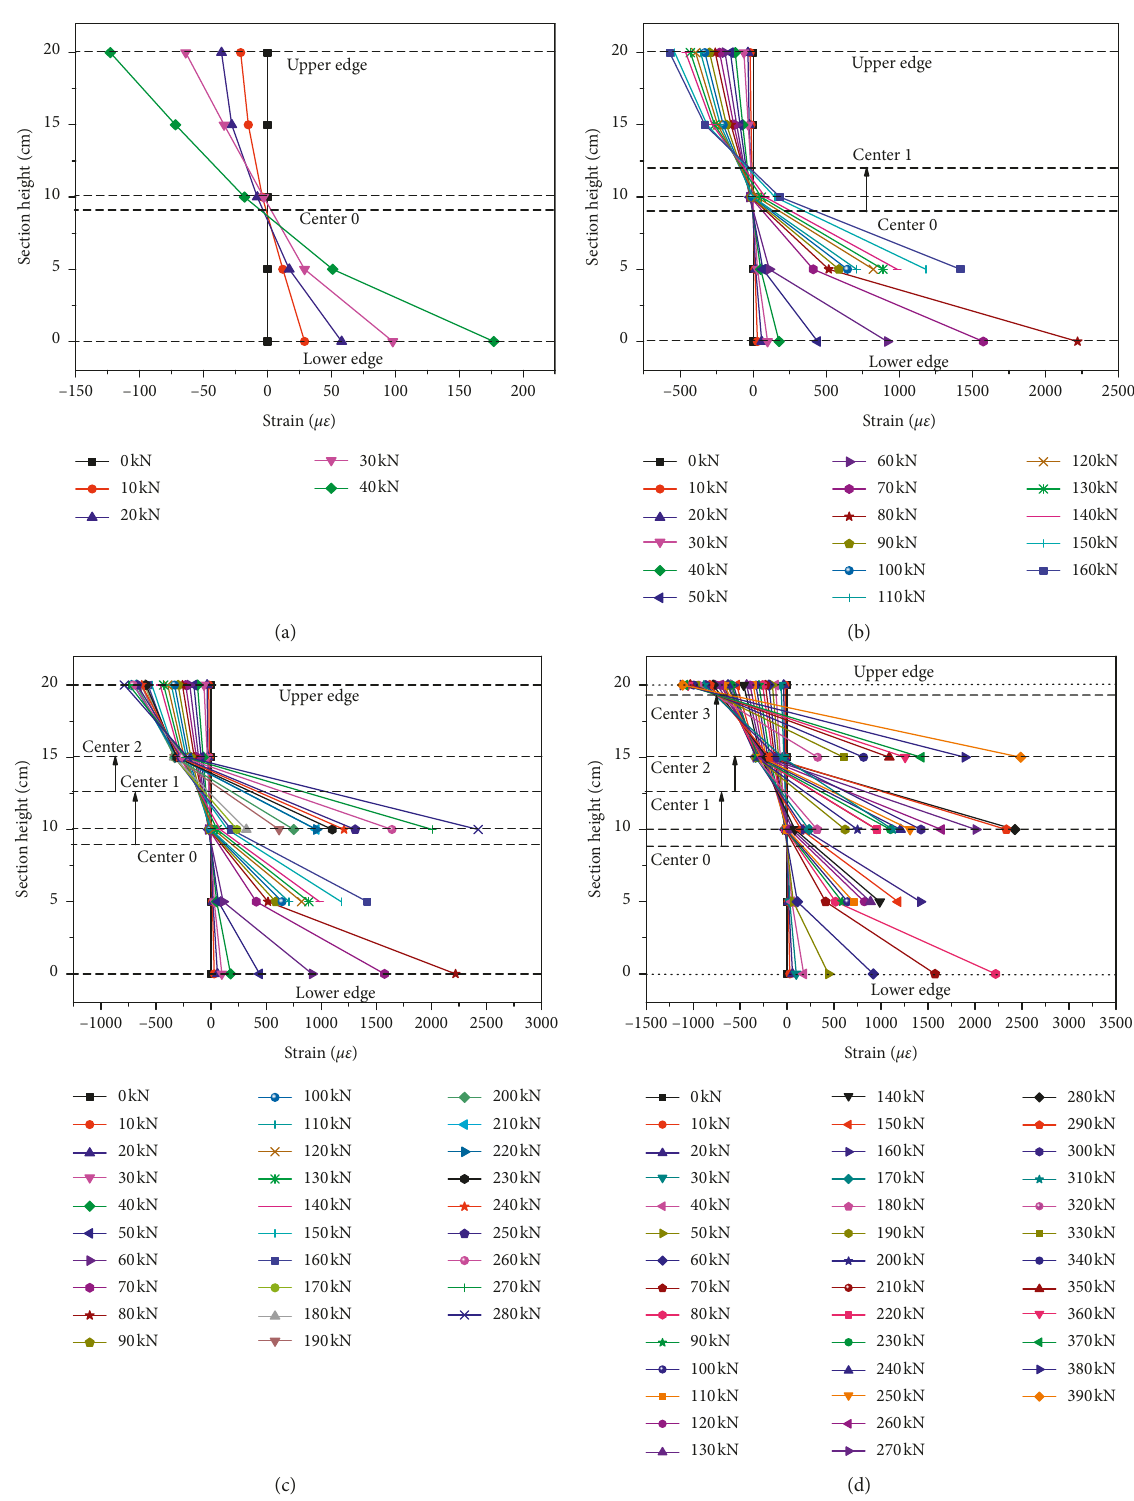
Figure 9: The relationship between section height and strain in different load levels: (a) 0–40 kN; (b) 0–160 kN; (c) 0–280 kN; (d) 0–390